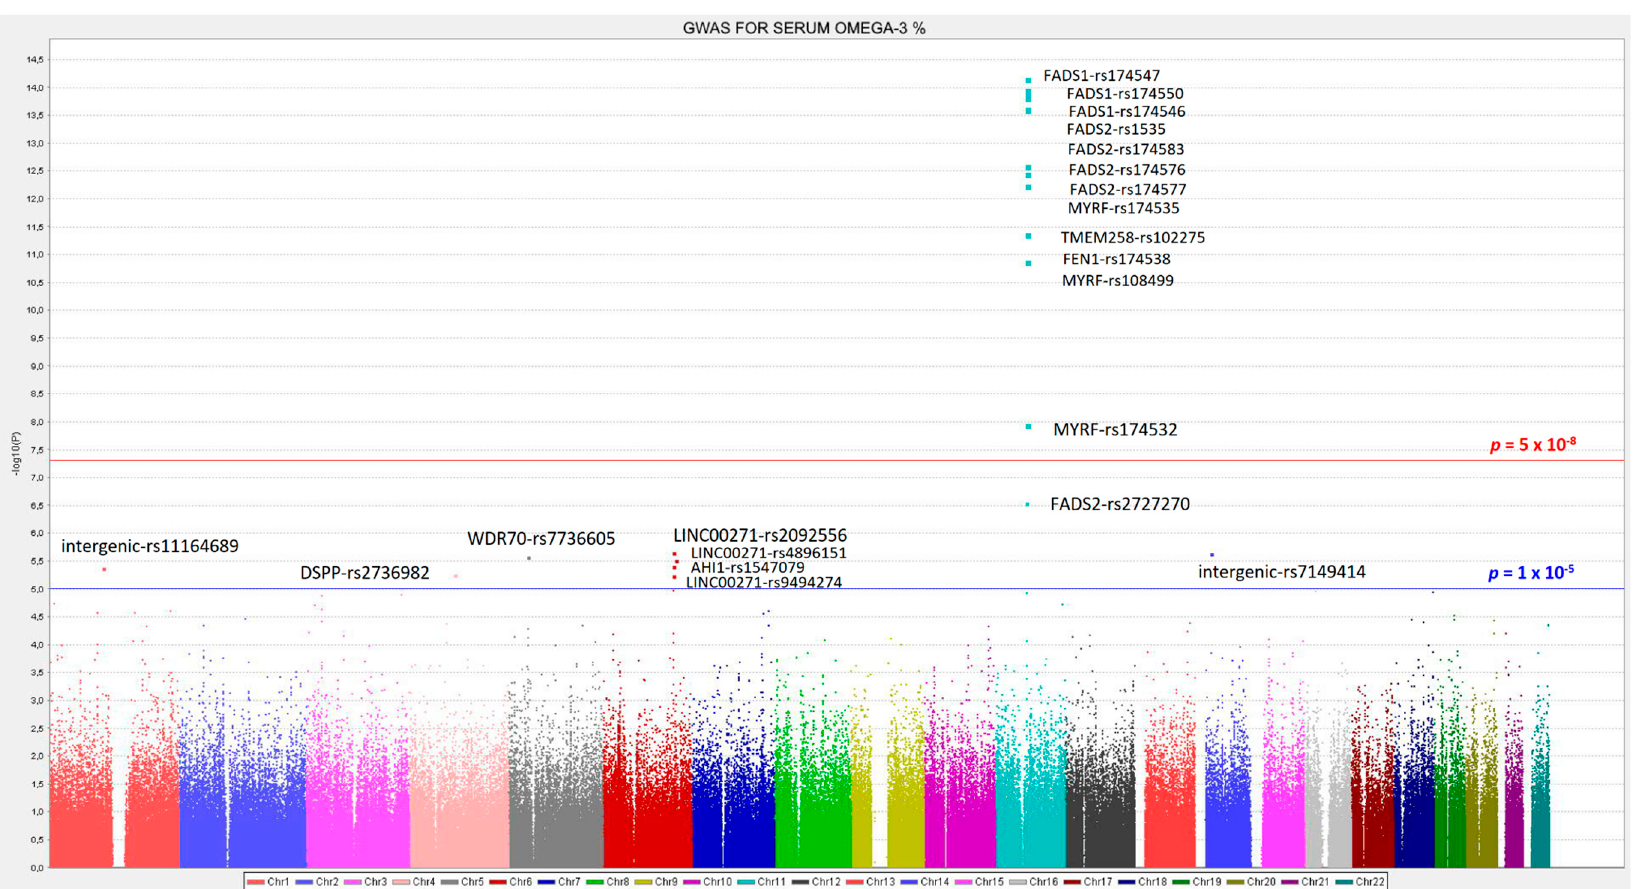
Figure 1. Manhattan plot for the genome-wide association study (GWAS) of serum omega-3 fatty acid (%) in the whole population. Associations were obtained from the genetic additive model and p -values were expressed as − log 10 ( p -value). The red line represents the threshold for GWAS statistical signi fi cance ( − log 10 (5 × 10 − 8 )). The blue line represents the threshold for suggestive GWAS signi fi cance ( − log 10 (1 × 10 − 5 )).